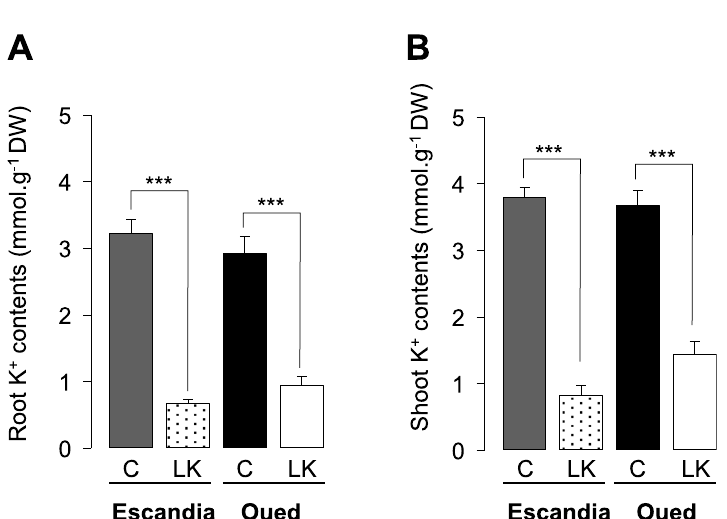
Fig. 2 Effects of K + shortage on K + contents in Escandia and Oued Zenati wheat seedlings grown in rhizobox‑type devices. Escandia and Oued Zenati wheat seedlings were grown in rhizoboxes for 14 days. The modified Hoagland nutrient solution contained either 6 mM (control (“C”)) or 60 µM K + (low K + (“LK”) condition). Root ( A ) and shoot ( B ) K. + contents were measured by flame spectrophotometry. Means Zenati and 6 for Escandia). *** indicates that the difference between the values in control condition and the corresponding values in LK condition is statistically significant (Student t test; p < 0.005)